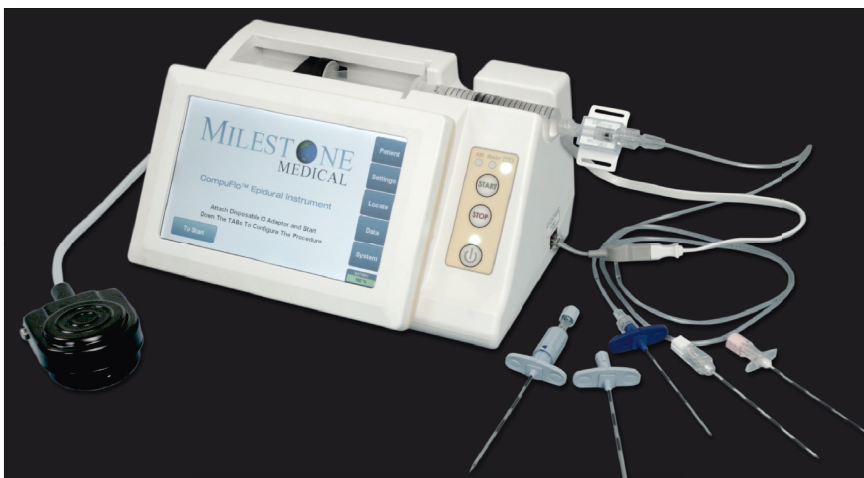
Figure 1: The CompuFlo ® epidural instrument.